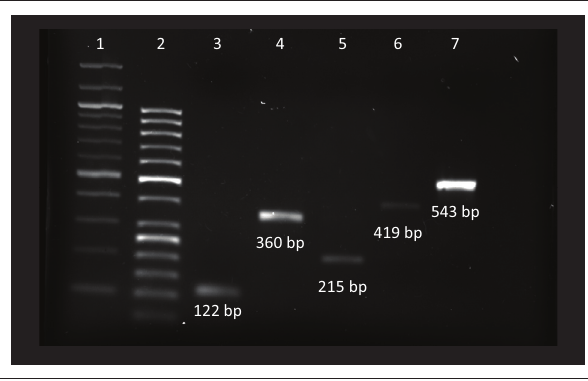
bp, base pair. FIGURE 1: Represents the successful genomic DNA amplification of the tuf gene (112 bp), from dog rectal sample 6 in lane 3 , SodA gene for Enterococcus faecalis from dog saliva sample 25 (360 bp) and Enterococcus faecium from chicken cloacal sample 20 (215 bp) in lane 4 and lane 5, respectively, gelE (419 bp) in lane 6 and the ccf gene (543 bp) in lane 7 from chicken cloacal sample 10. Lane 1 and lane 2 are 100 bp and 50 bp molecular weight markers,